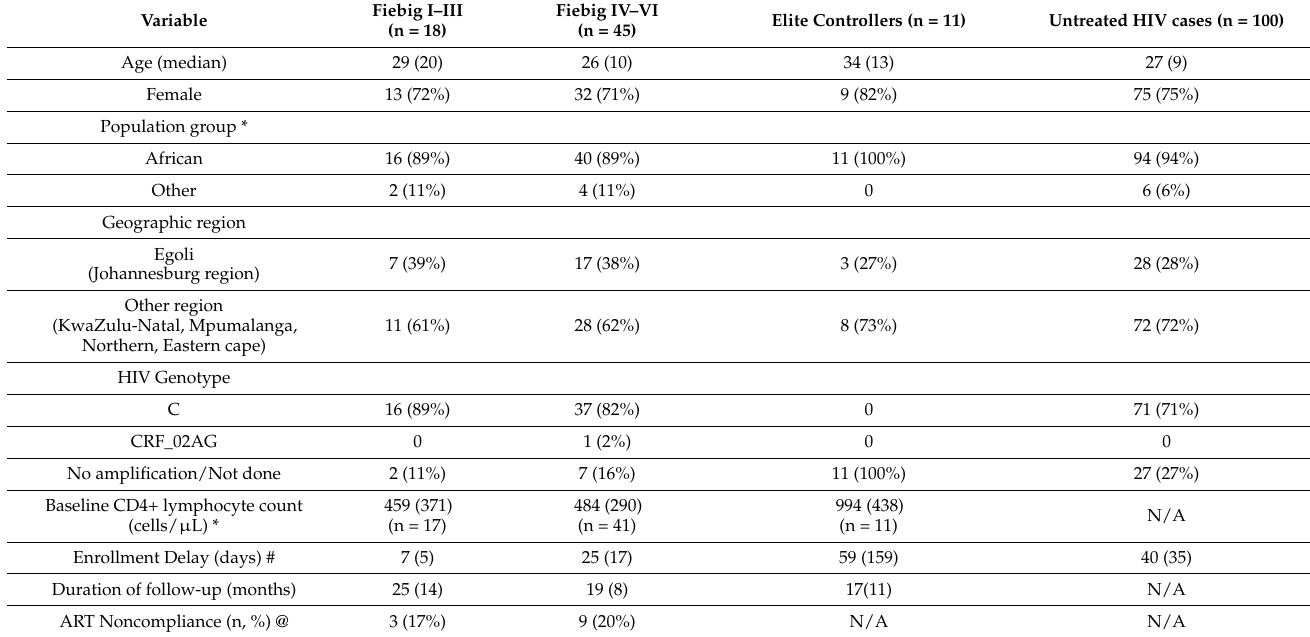
Table 1. Characteristics of the study population, by Fiebig stage at time of treatment initiation and in the untreated HIV comparison group. Numerical variables are presented as median (interquartile range (IQR)) and categorical variables as n